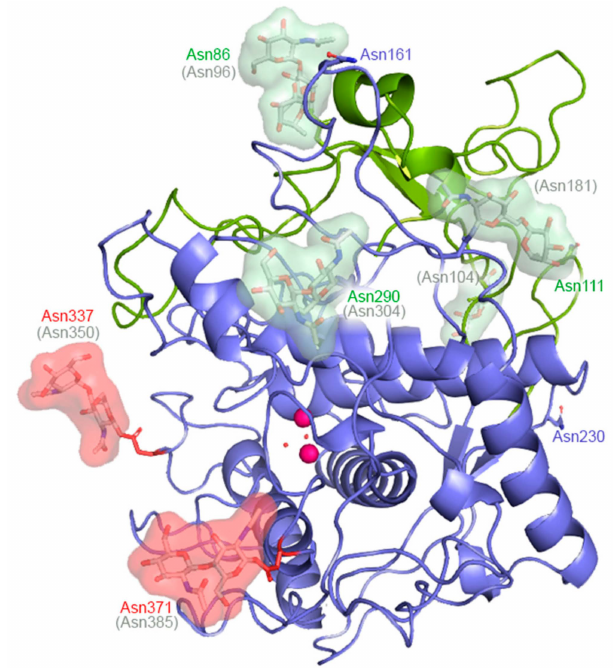
Figure 5. Location of the N -glycosylation sites in the model of human TYR and the crystal structure of glycosylated human TYRP1 (PDB 58ML [4]). The Asn residues of the N -glycosylation sequons (Asn-X-Ser / Thr) (Figure 4) in human TYR (in color) and human TYRP1 (in grey) are labelled. Glycans observed in the human TYRP1 crystal structure are depicted as sticks. Disease-associated Asn mutation sites are shown as red surfaces; the other N -glycosylation sites are shown as green surfaces. The tyrosinase-like domain is shown in blue and the Cys-rich domain in green. Metal ions are shown as pink spheres and coordinating waters are in